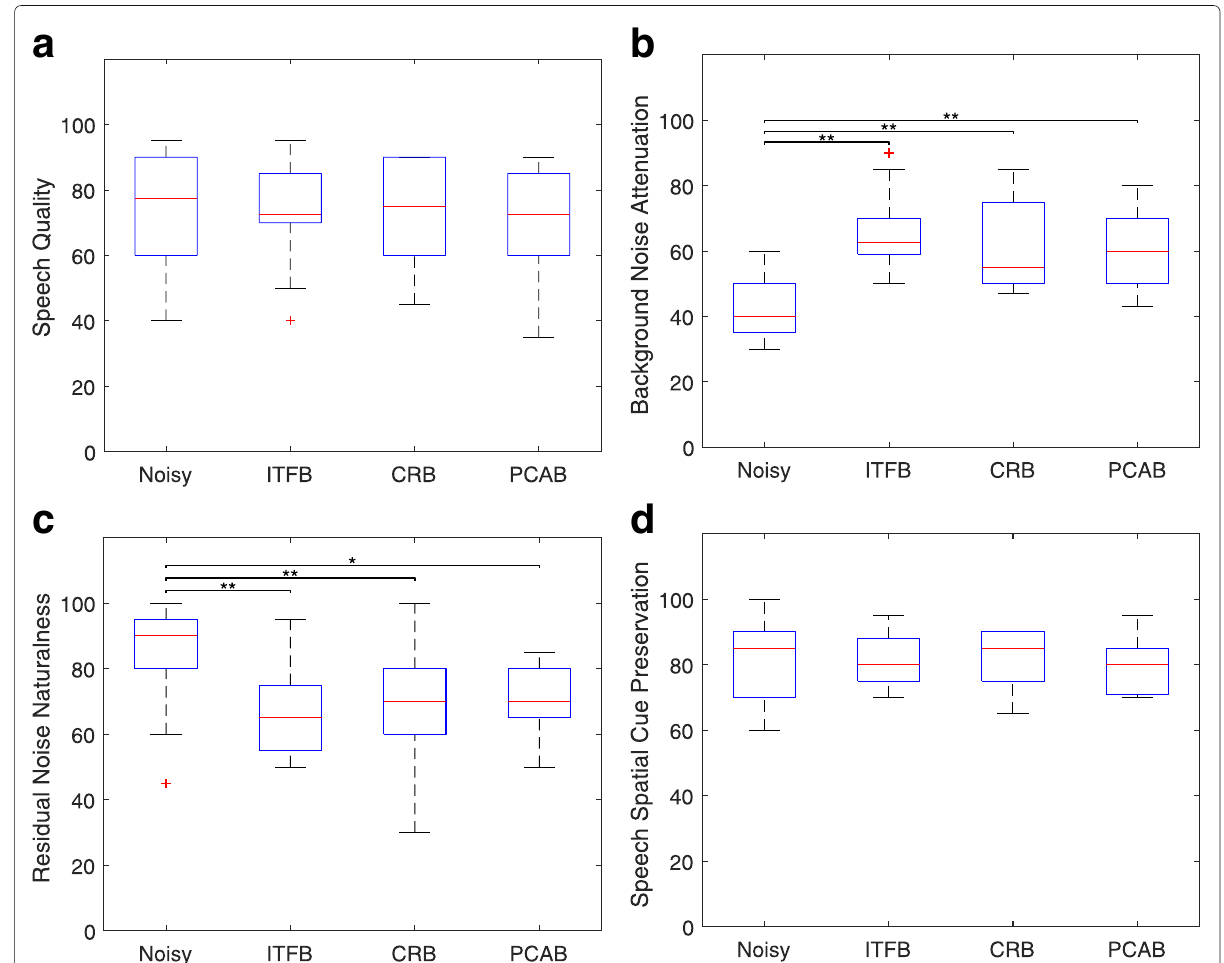
Fig. 12 Boxplots for a speech quality, b background noise attenuation, c residual noise naturalness, and d speech spatial cue preservation for an approximately diffuse noise, where SNR ≈ 6 dB according to the Lombard effect